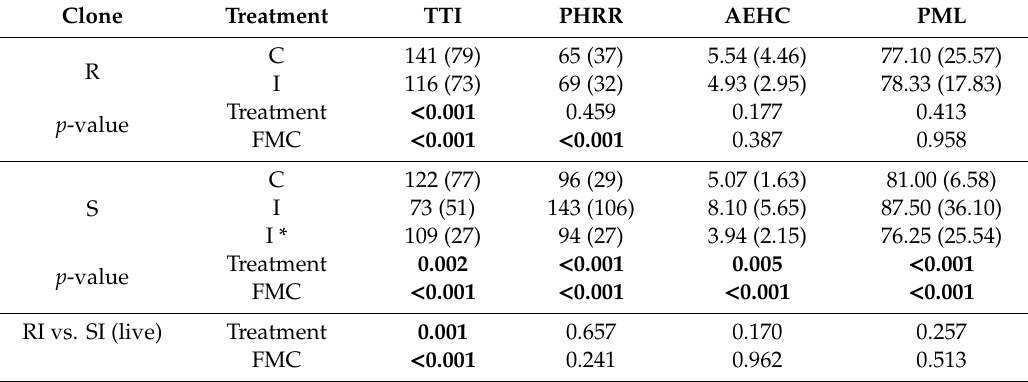
Table 6. GLMM of the flammability parameters of the resistant (R) and susceptible (S) common cypress clones comparing the control (C) and infected (I) treatments for the following variables: TTI (time to ignition, s, PHRR (peak heat release rate, kW / m 2 ), AEHC (average e ff ective heat of combustion, MJ / Kg), PML (percentage of mass lost, %). The average and standard deviation (in brackets) for each variable and treatment are shown (N = 9). The fuel moisture content (FMC) is used as a covariable. The model for the SI treatment was repeated removing the dead samples (*). The p -value indicates the significance of the fixed variables (treatment, C vs. I). Significant di ff erences ( > 95%) are highlighted in bold.